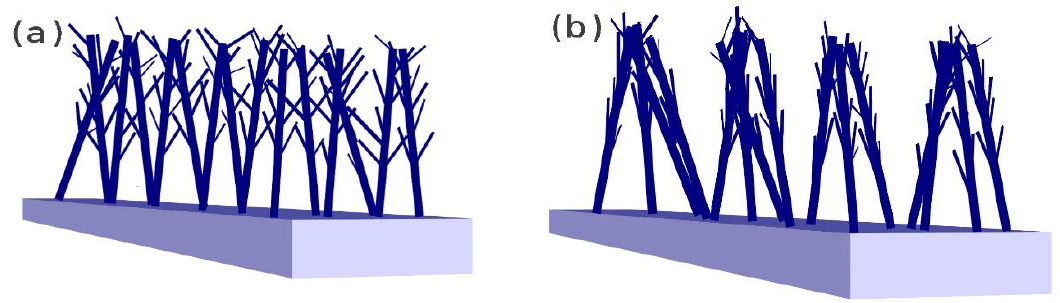
Figure 9. Scheme of randomly oriented silicon NTrs: ( a ) dry, ( b ) after wetting.